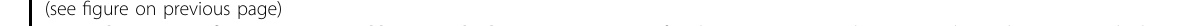
Fig. 2 The activity of HIF-1 is increased by BTG3 depletion. a Expression of endogenous COX2 and VEGF was elevated upon BTG3 depletion in a HIF-1 α -dependent manner. RNA was isolated from siRNA-transfected IMR90 cells and analyzed by RT-PCR. b Transcriptional activity of HIF-1 α was enhanced in BTG3-downregulated cells. IMR-90 cells were fi rst transfected with siRNA for 24 h then transfected with a luciferase reporter carrying four copies of the hypoxia response element (4×HRE). Cells were either left untreated or treated with hypoxia for 18 h prior to collection. All values were normalized to the cotransfected internal control. Western blots show the levels of BTG3 and HIF-1 α under the treatment condition. c HRE in the COX- 2 promoter was stimulated by BTG3 downregulation. Conditions were as in ( b ) but using the COX-2 reporter. d Overexpression of BTG3 suppressed the transcriptional activity of HIF-1 α as assessed with the COX-2 reporter. e Selective induction of known HIF-1 targets in BTG3 knockdown IMR90 cells. SCF, but not Glu1 or ANGPT2, was induced by BTG3 downregulation, as assessed by RT-PCR. f BTG3 downregulation does not increase intracellular